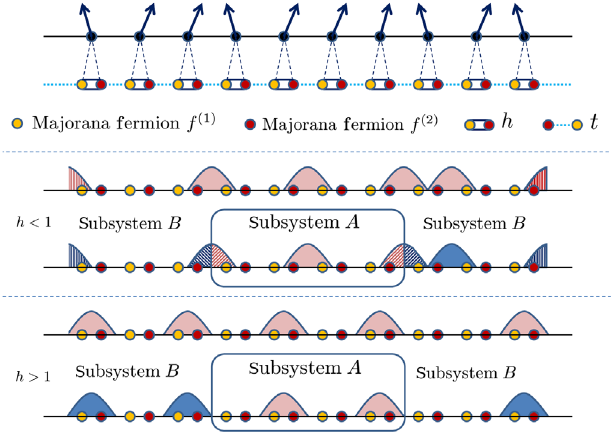
FIG. 1. Top: The Ising chain is mapped into a system of Majorana fermions by doubling the lattice sites. Center and bottom: A schematic of the quasiparticle excitations in the two phases and the effect of bipartitioning the system; for small h , edge states form at the opposite boundaries of subsystem A . The property of local convertibility depends on the correlations between such edge